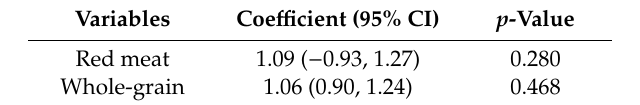
Table 5. The association between red meat and whole-grain intake and MUC2 expression data ( n =